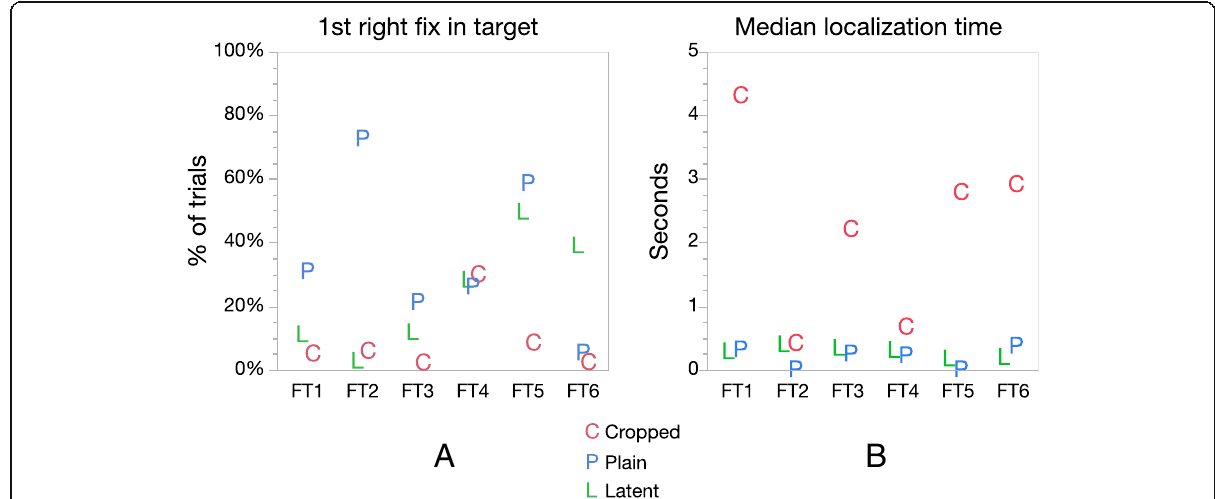
Fig. 7 Two measures of rapid localization, by task type and image set. a Proportion of trials in which the first fixation in the right image was in the target. b Median localization time, measured from the first fixation in the right image to the first fixation in the target area on the right image. See Additional file 1: Appendix SI-8 for distributions of localization times. ( n = 626 trials; 4 trials had no